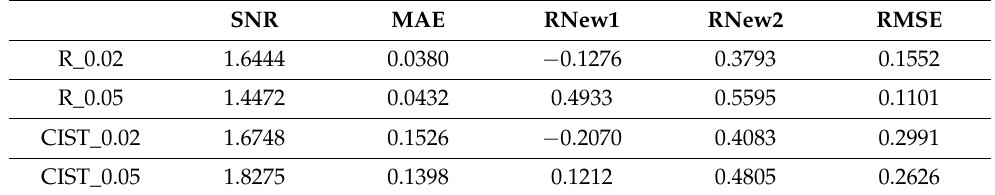
Table 1. Analysis of fitting errors.